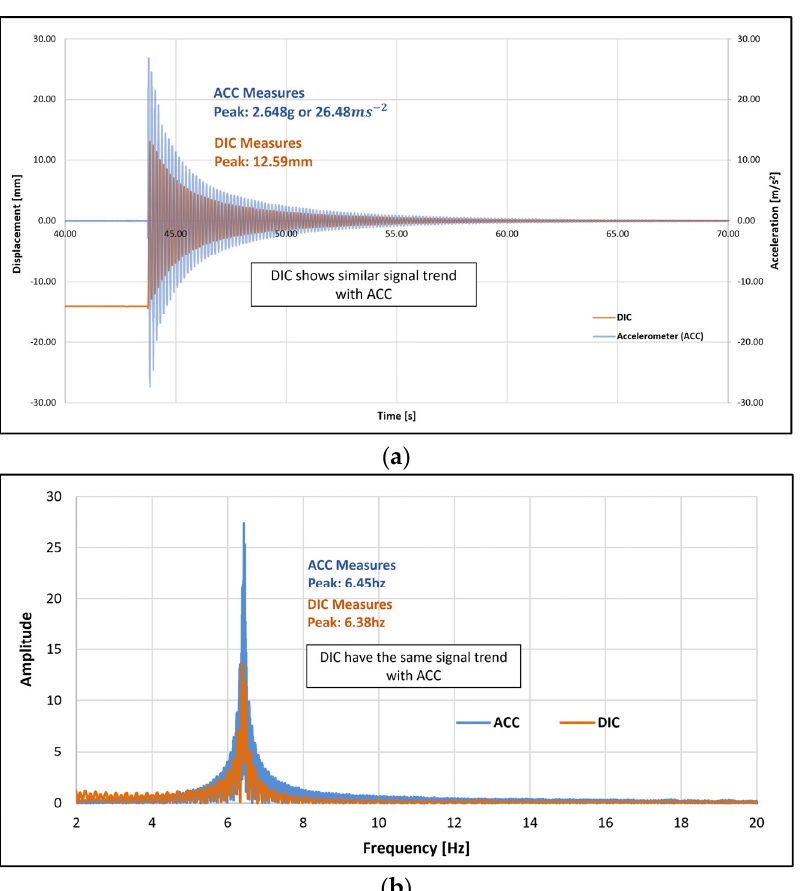
Figure 5. Comparison of ( a ) the free vibration frequency measurement using the accelerometer and the DIC, ( b ) the FFT amplitude peak values of the accelerometer and the DIC.